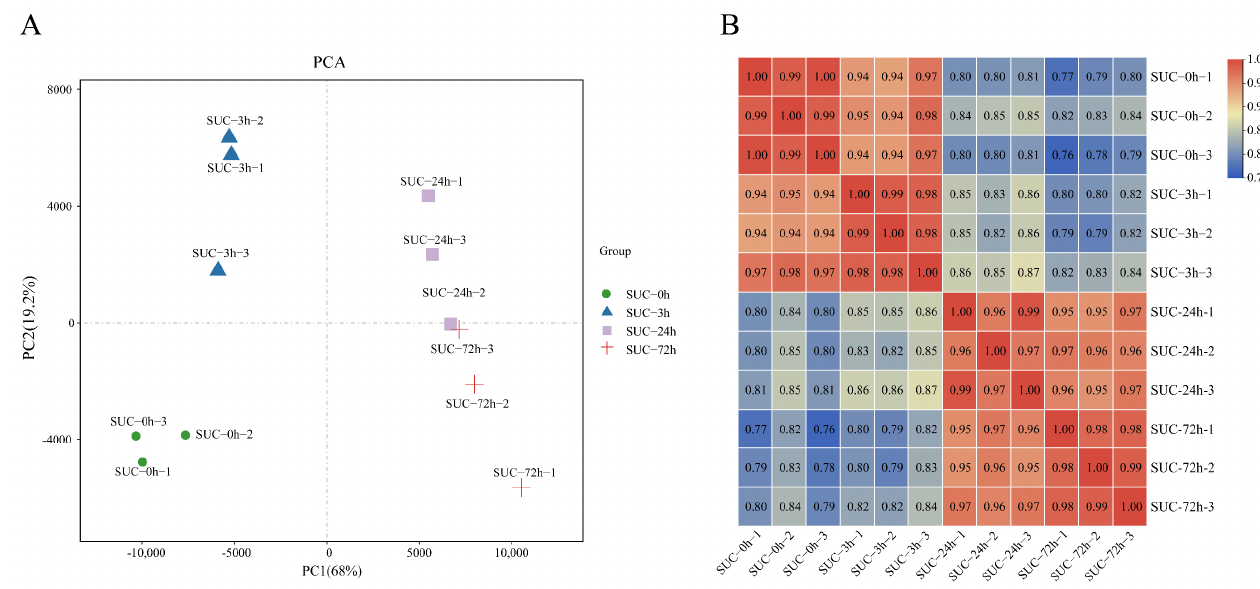
Figure 2. Correlation analysis of samples under sucrose treatment at different time points. ( A ) Principal component analysis (PCA) of samples subjected to sucrose treatment at different time points. ( B ) Pearson’s correlation coefficient analysis of the 12 samples under sucrose treatment at indicated time points. The red scale indicates a high correlation, and the blue scale indicates a low correlation. Based on the RNA-seq data, genes with FDR ≤ 0.05 and |log2FC| ≥ 1 were identified